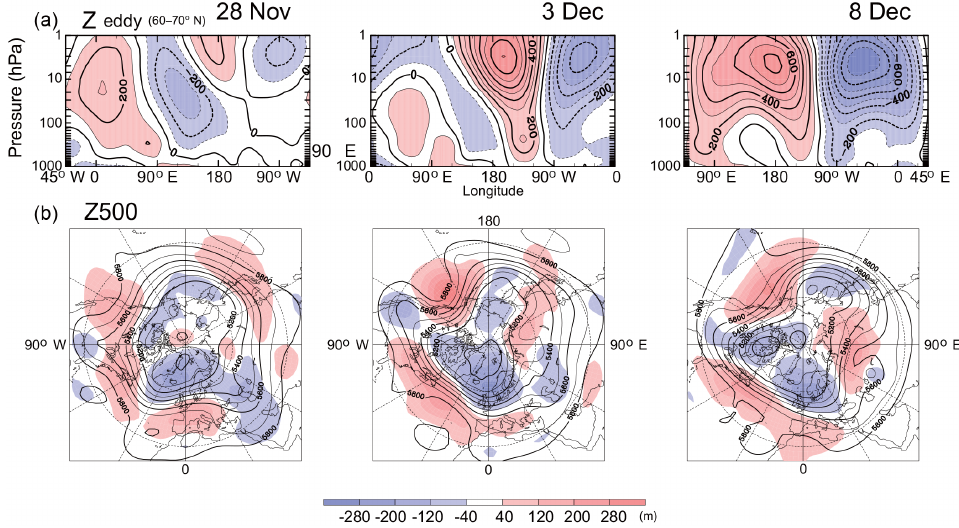
Figure 5. (a) Latitude–height section of the 5-day-mean zonally asymmetric component of geopotential height (m) averaged over 60–70 ◦ N. The origin of the longitude shifts eastward with time: 45 ◦ W, 0 ◦ , and 45 ◦ E from left to right. (b) The 5-day-mean 500hPa geopotential height (contours) and deviation from the climatology (colour shading). The analysis period is the same as in Fig.